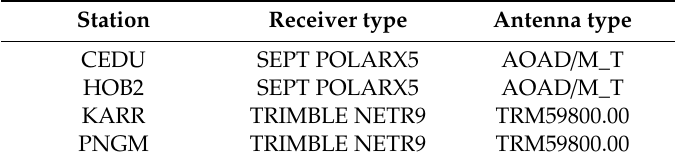
Table 2. Stations selected for the investigation of ISB characterization affected by the ambient environment.